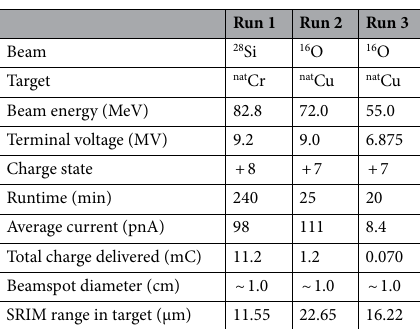
Table 1. Experimental run